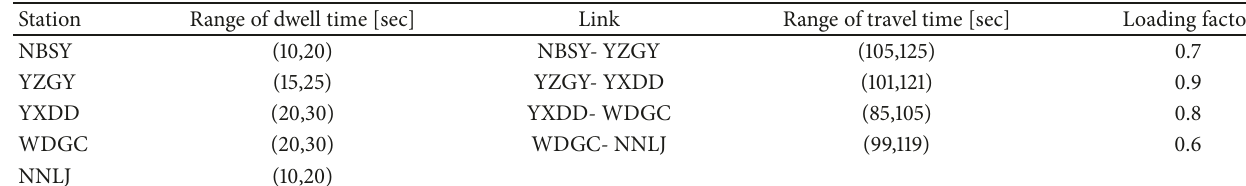
Table 8: Tram timetable formulation parameters and loading factors.